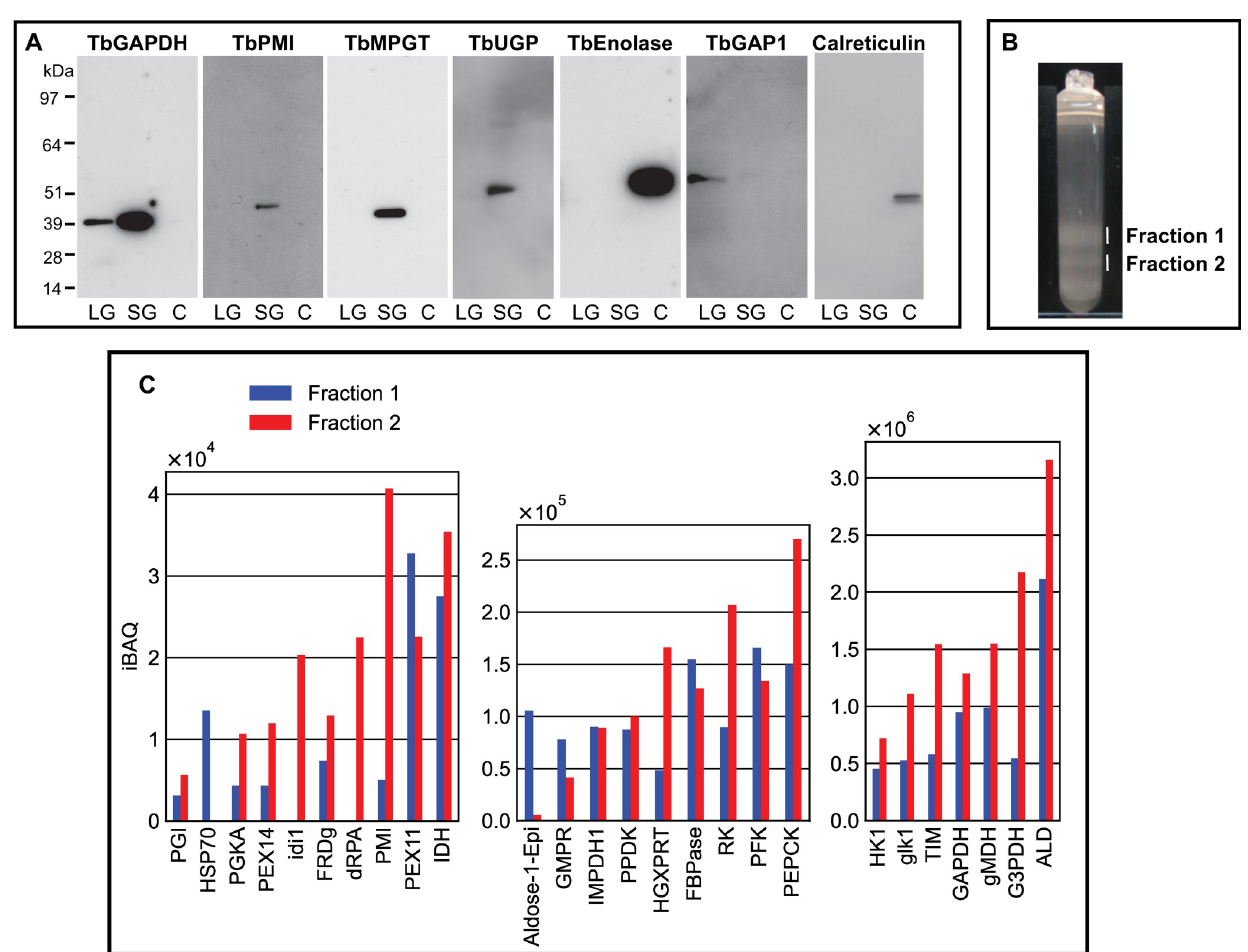
Fig 6. Subcellular localization by subcellular fractionation and evidence for glycosome heterogeneity by density gradient centrifugation and proteomics. Panel A: Pcf trypanosome lysate was submitted to differential centrifugation [70] and aliquots of the large granular (LG), small granular (SG) and cytosolic plus microsomal fractions (C) were subjected to SDS-PAGE and Western blotting with antibodies to authentic glycosomal (TbGAPDH), mitochondrial (TbGAP1), cytoplasmic (TbENO) and ER (calreticulin) markers and to NS biosynthetic enzymes (TbPMI, TbMPGT and TbUGP), as indicated. Panel B: The SG fraction was further fractionated by iodixanol density gradient centrifugation and two opalescent bands (fractions 1 and 2) were isolated. Panel 3: Aliquots of fractions 1 and 2 from panel B were subjected to proteomic analysis by LC-MS/MS. The relative abundances (iBAQ values over three scales, y-axes) are plotted against the identified proteins (TriTrypDB identifiers, x-axes).